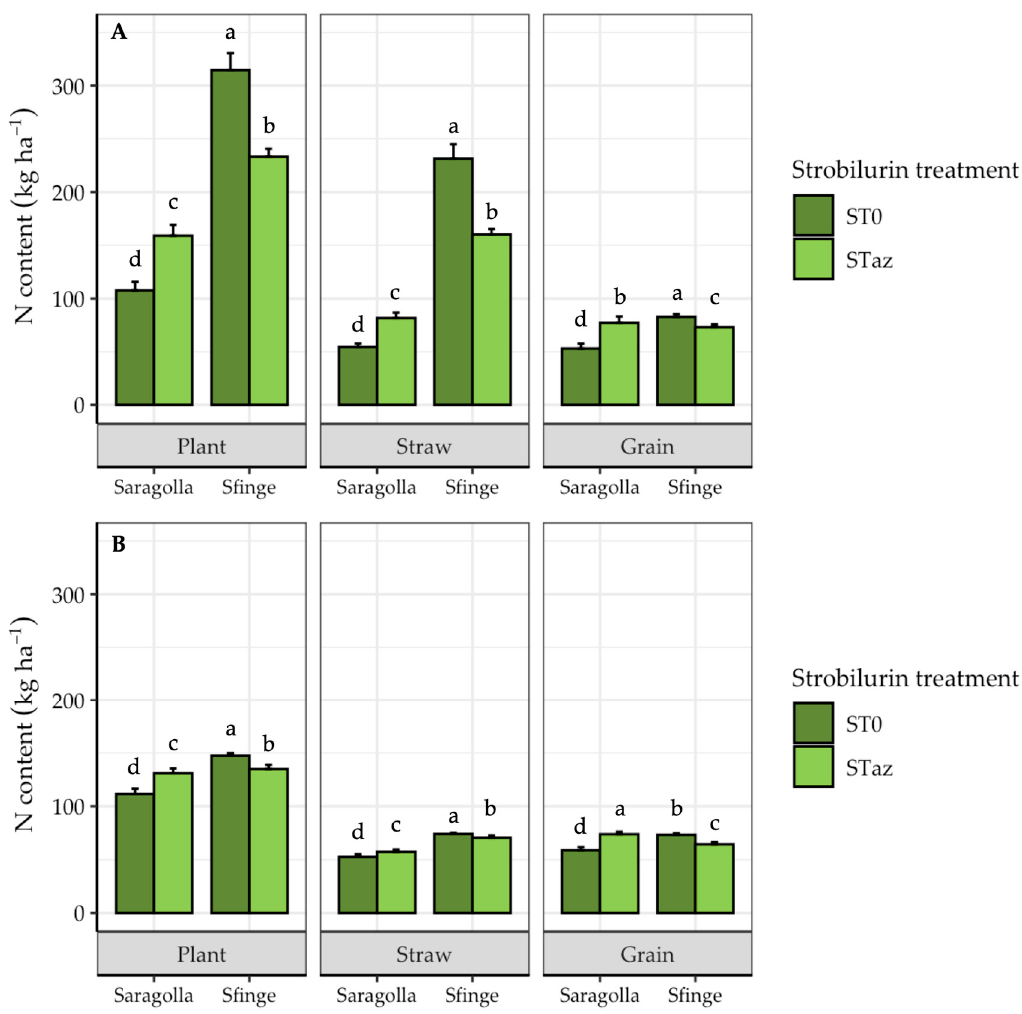
Figure 2. E ff ect of the interactions between cultivar and strobilurin treatment in 2011 ( A ) and 2012 ( B ) for plant, straw and grain N content. ST0, no strobilurin treatment; STaz, strobilurin treatment. Values with di ff erent letters are significantly di ff erent at p ≤ 0.05 according to Tukey’s test. Vertical bars indicate standard errors ( n = 15).